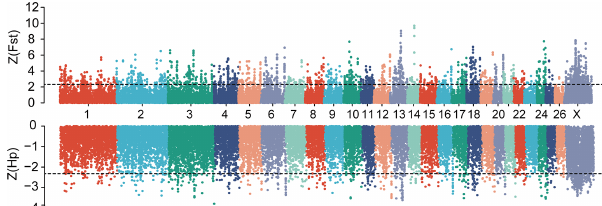
Figure 2. Manhattan plot of genome-wide selective sweep signals ( Z ( F st ) and Z ( H p ) HU ) in two sheep breeds. For each metric, a 150kb sliding window with a step size of 50kb was applied. The positive selected regions were extracted at the extreme ends of the distribution by applying Z ( F st ) > 2 . 326 and Z ( H p ) < − 2 . 326 cut- offs.